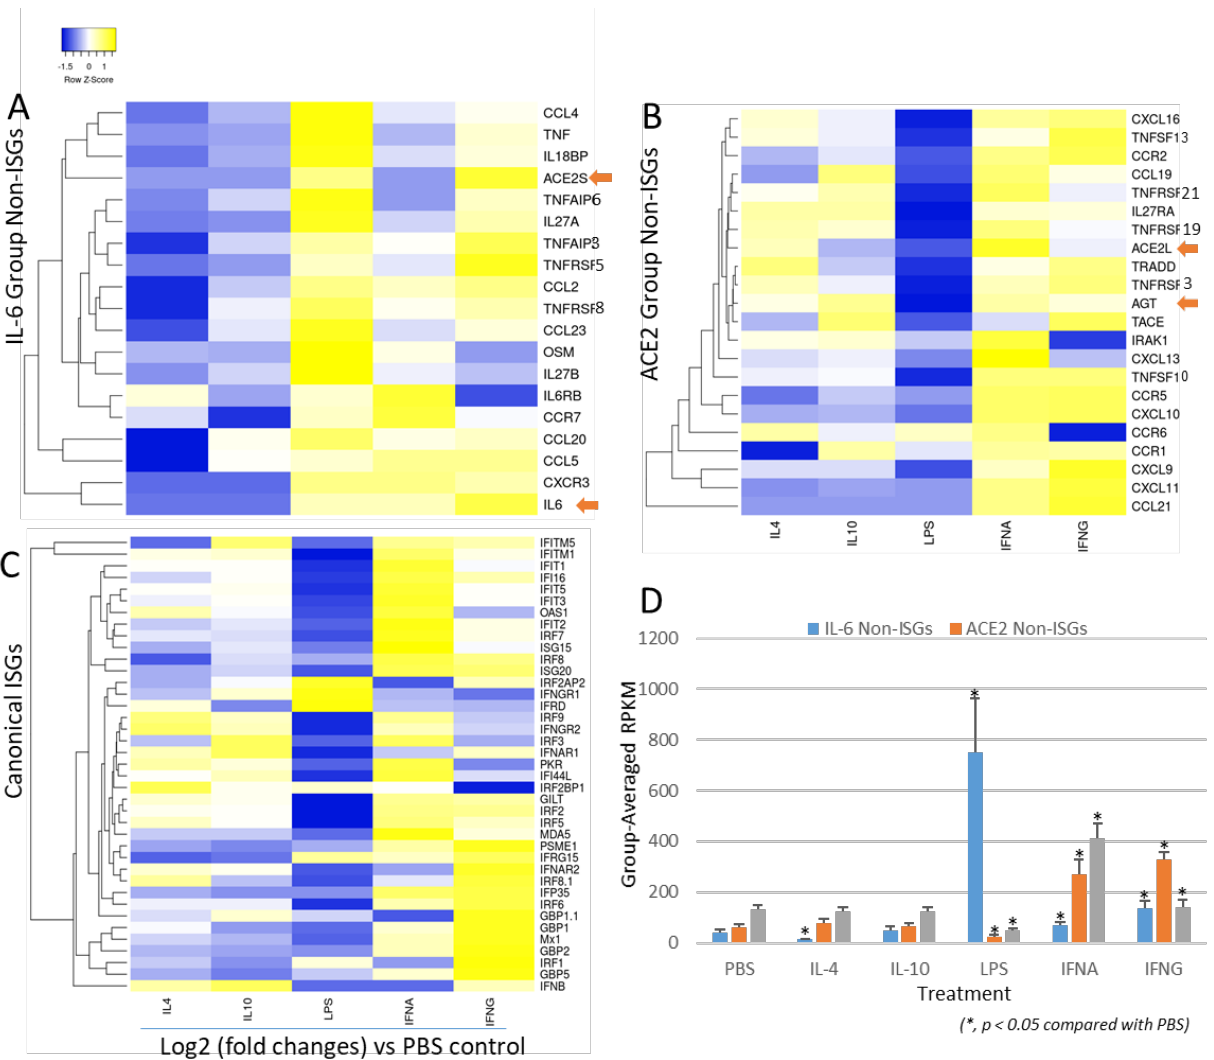
Figure 8. Genome-wide categorizing non-ISGs based on the similarity of inductive pattern to IL-6 and ACE2 genes. The non-biased genome-wide transcriptomic data were generated using an RNA-Seq procedure in porcine lung macrophages stimulated with each activation stimulator of IL-4, IL-10, LPS, IFN- α or IFN- γ at 20 ng/mL and infected by porcine arterivirus virus for 5 h, using an Illumina procedure as previously described [57]. Significantly differentially expressed genes (DEGs) in the renin–angiotensin system (RAS), interleukin (IL)-6, TNF, and chemokine super-families were annotated and grouped using heatmaps according to their inductive expression patterns similar to: ( A ) IL-6, ( B ) ACE2; ( C ) Examples of canonical ISGs as reference; ( D ) Averaged transcriptomic expression levels (normalized at reads per kilobase of transcript per million mapped reads, RPKM) of the grouped ISGs or non-ISGs above. Indicated by arrows, pigs have two ACE2 isoforms, namely ACE2L and ACE2S, which have different expression patterns; ACE2S similar to IL-6 showed to be less responsive to IFN- α but highly responsive to LPS and IFN - γ. In cont rast, ACE2L and another key gene, AGT, in RAS were categorized together with other non-ISGs ( B ), which is more like the expression pattern of canonical ISGs ( C ) than the IL-6 group ( A ).